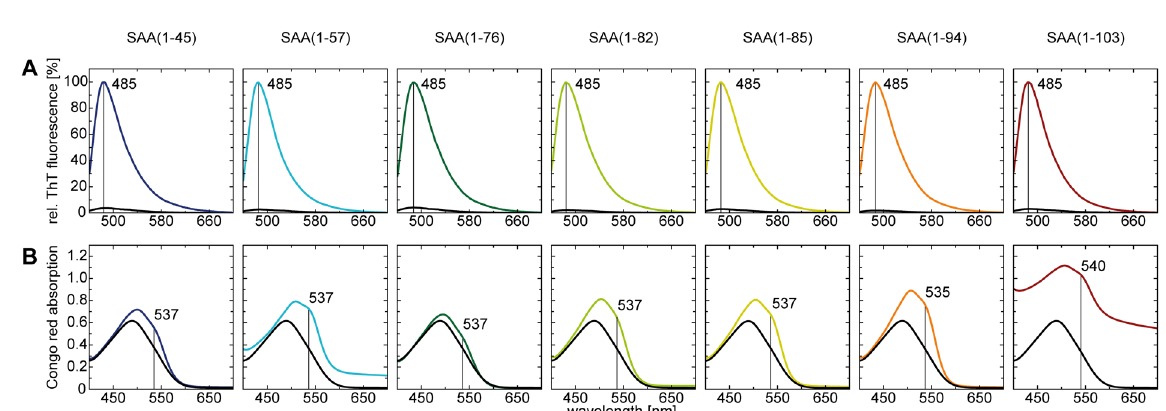
Figure 3. Binding properties of fibrils formed in vitro from SAA(1–103) and AA proteins to amyloid specific dyes. ( A ) Normalized ThT fluorescence spectra of ThT without (black) and with fibrils. ( B ) Congo red absorption spectra of pure Congo red solution (black) in comparison to spectra obtained by addition of preformed